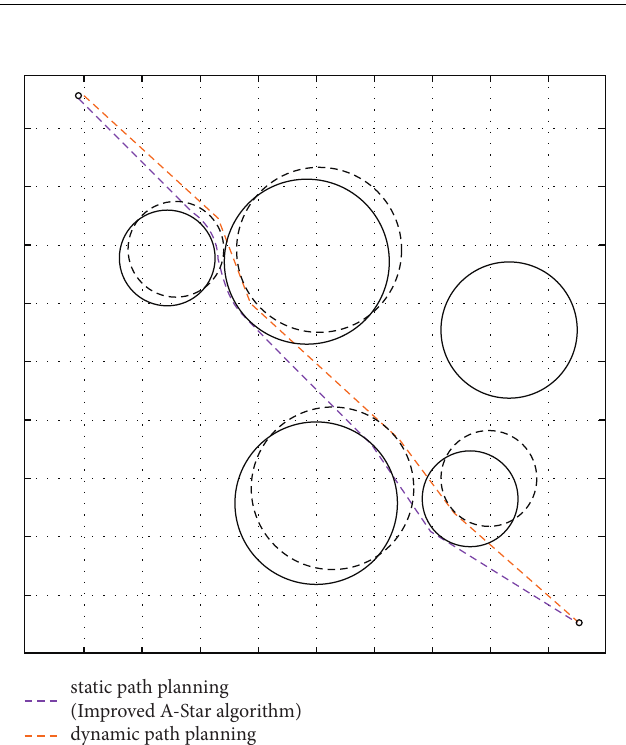
Figure 23: The results of dynamic path planning from Madrid to Cairo. Table 11: The results of dynamic path planning from Algiers to